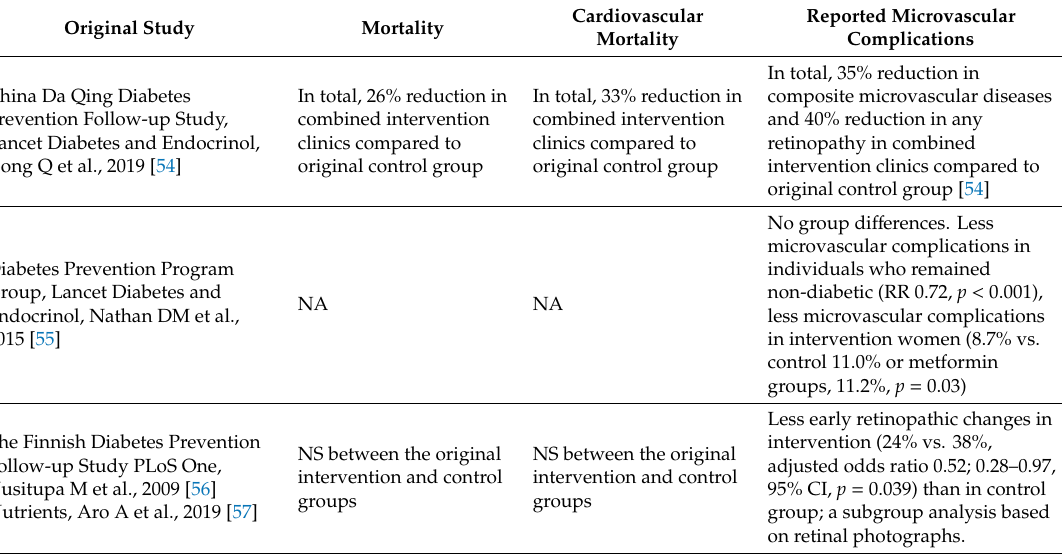
Table 5. Long-term post-intervention data on mortality, cardiovascular (CVD) mortality and microvascular complications in the former intervention groups compared to the control groups in three randomized controlled lifestyle intervention